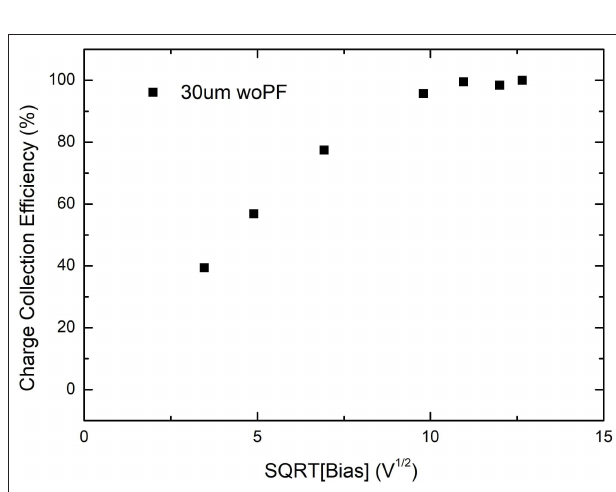
FIGURE 9 | CCE vs. sqrt(V) for the 30 µ m thick a-Si:H n-i-p device without activation of the Poole-Frenkel trap